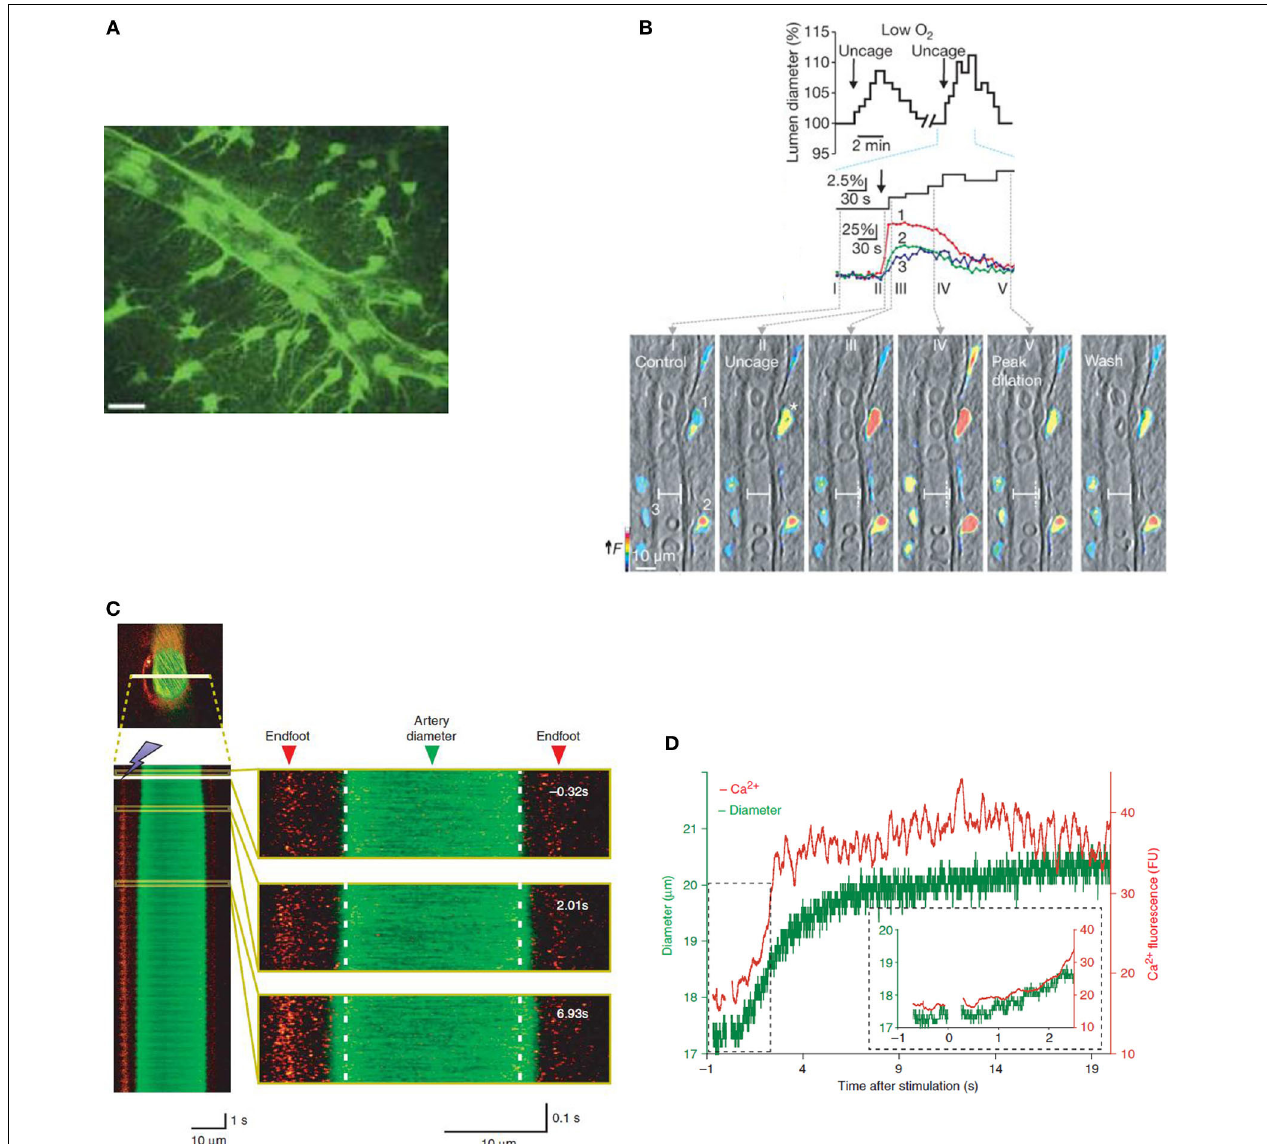
Macmillan Publishers Ltd., Nature (Gordon et al., 2008) copyright (2008). (C) Vessel diameter changes can be measured in mouse cortex in vivo using 2-photon microscopy in line scan mode. Here, calcium is measured using rhod-2/AMandvesselsarevisualizedwithadextran-coupleddye.Left,linescan image of an artery exposed to photolysis of caged Ca 2 + which increases astrocyte [Ca 2 + ] i . Astrocytic Ca 2 + and vessel diameter increase almost simultaneously following photolysis. Right, larger views of line scan section indicated in yellow boxes. (D) Time course of changes in astrocyte [Ca 2 + ] i and vessel diameter in (C) . Reprinted by permission from Macmillan Publishers Ltd., Nature Neuroscience (Takano et al., 2006) copyright (2006).